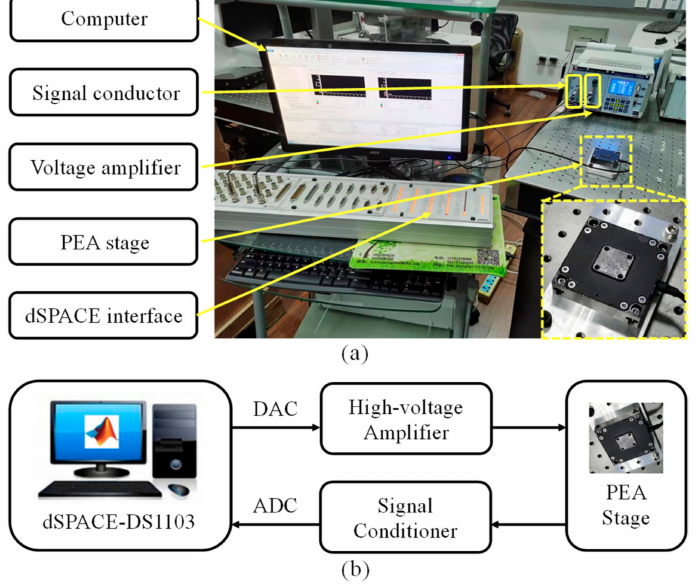
Figure 1. Experimental setup of PEA nano-positioning system: ( a ) experimental platform; ( b ) block